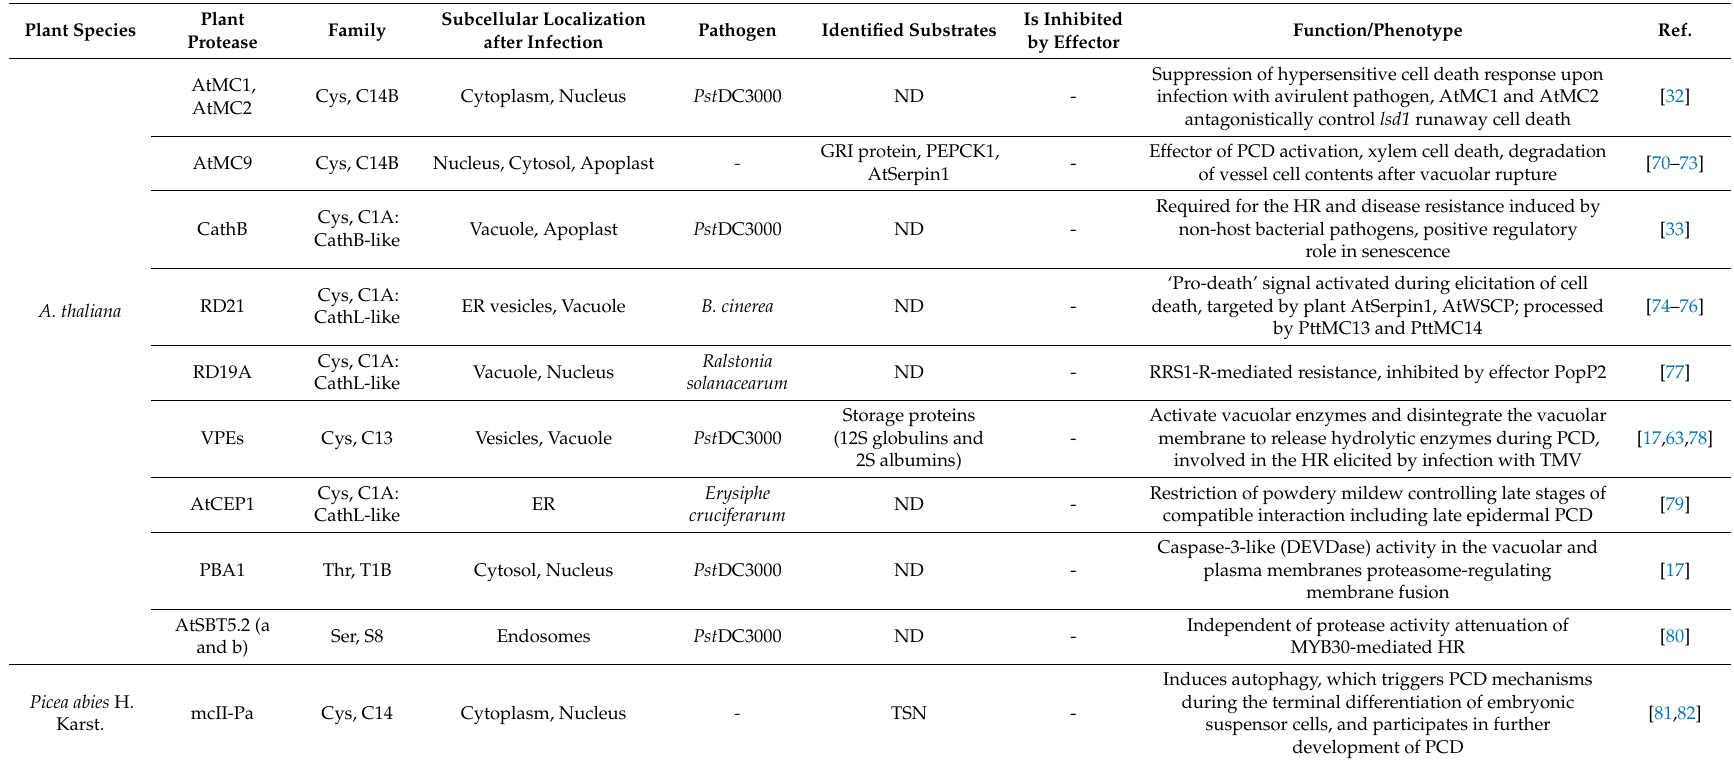
Table 1. Proteases involved in ETI responses and